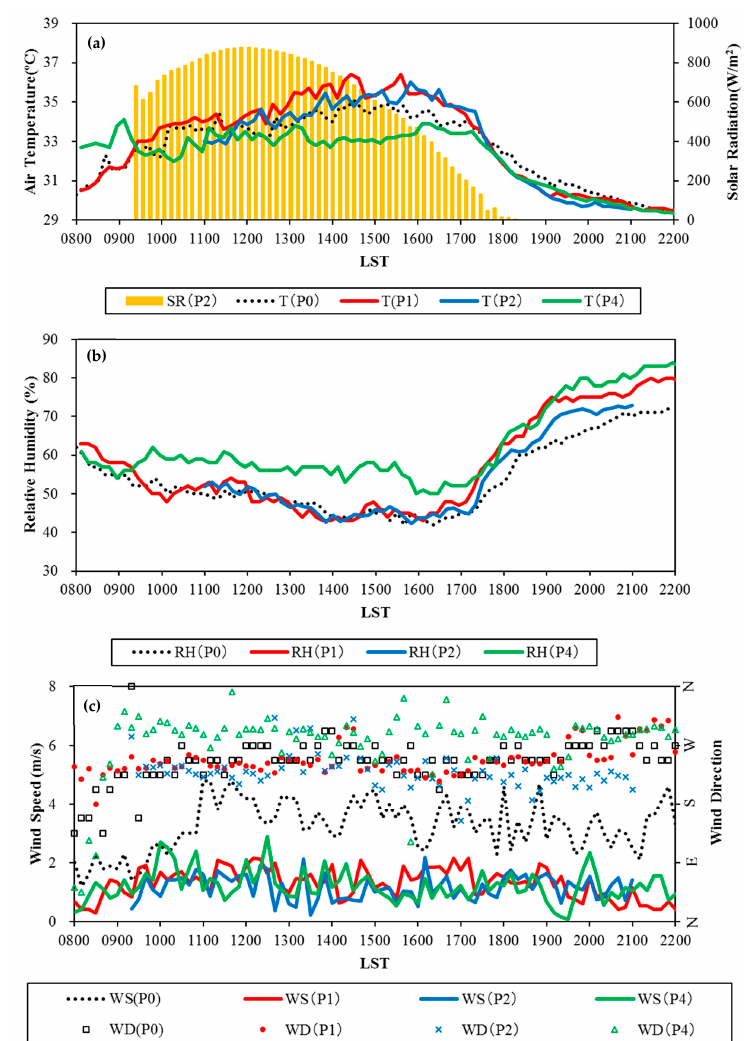
Figure 4. Time variations of meteorological elements on 31 August 2010. ( a ) SR: global solar radiation, T: Air temperature, ( b ) RH: Relative humidity. ( c ) WS: Wind speed, WD: Wind direction. P1, P2, and P4 are the stationary points. P0 is the Osaka Meteorological Observatory nearby the study area (see Figure 1b).